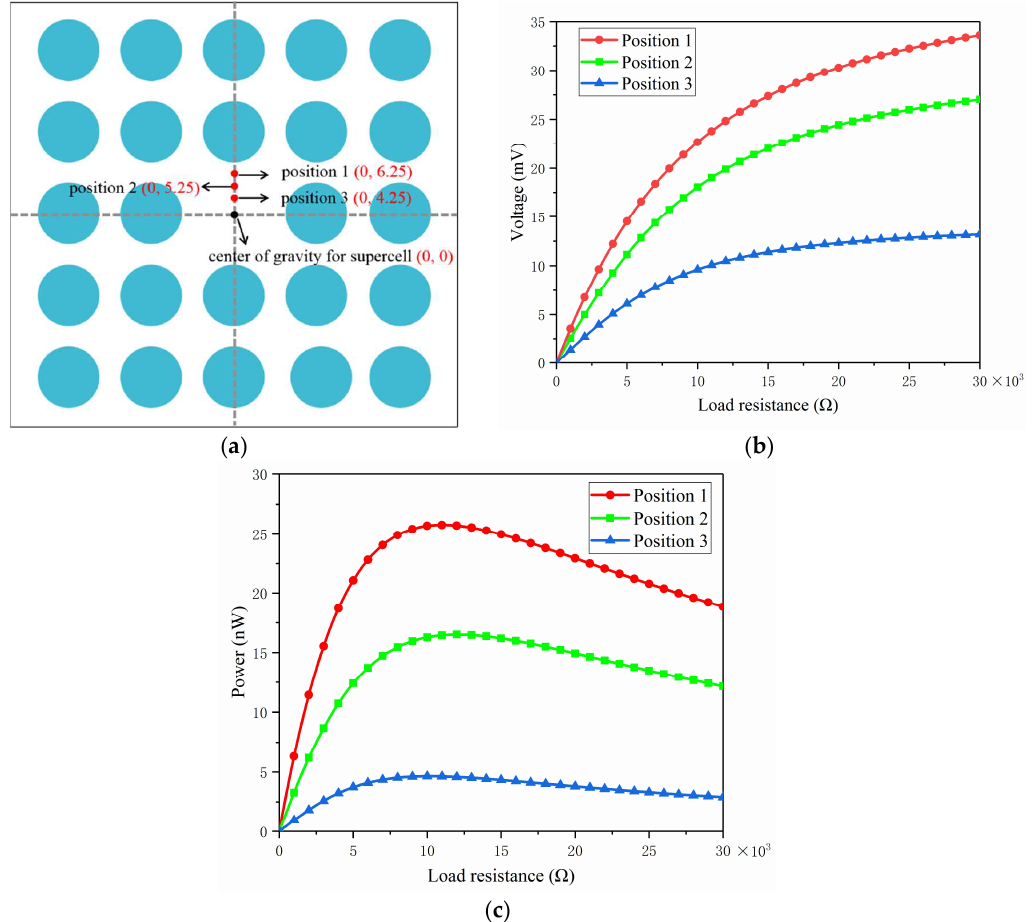
Figure 12. ( a ) Diagram of the piezoelectric patch placed in three di ff erent positions of the M-E PC with point defect. ( b , c ) show the output voltage and power of NBG4 th versus the load resistance for di ff erent positions of the piezoelectric patch at σ z = 0 MPa, H z = 1